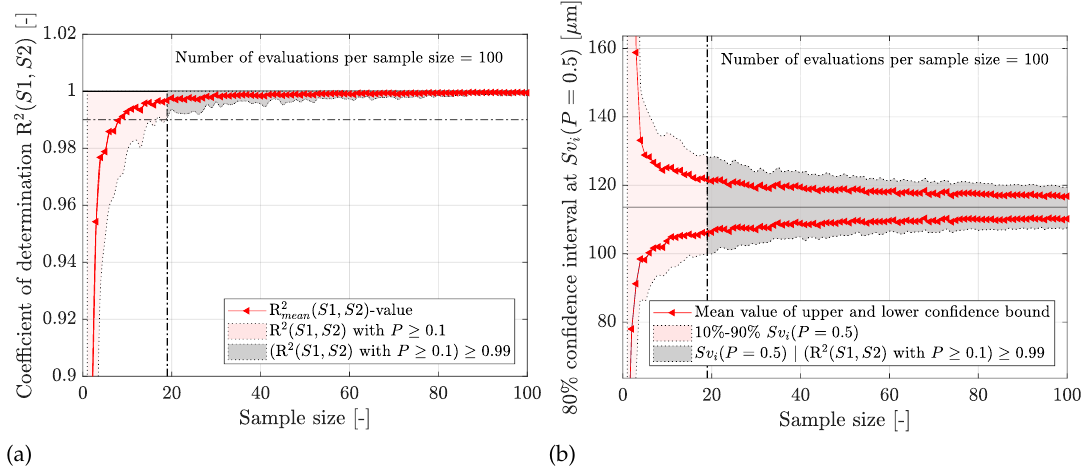
Figure 16. Sample size effect on ( a ) Sv i -GEV distribution. ( b ) Confidence interval.